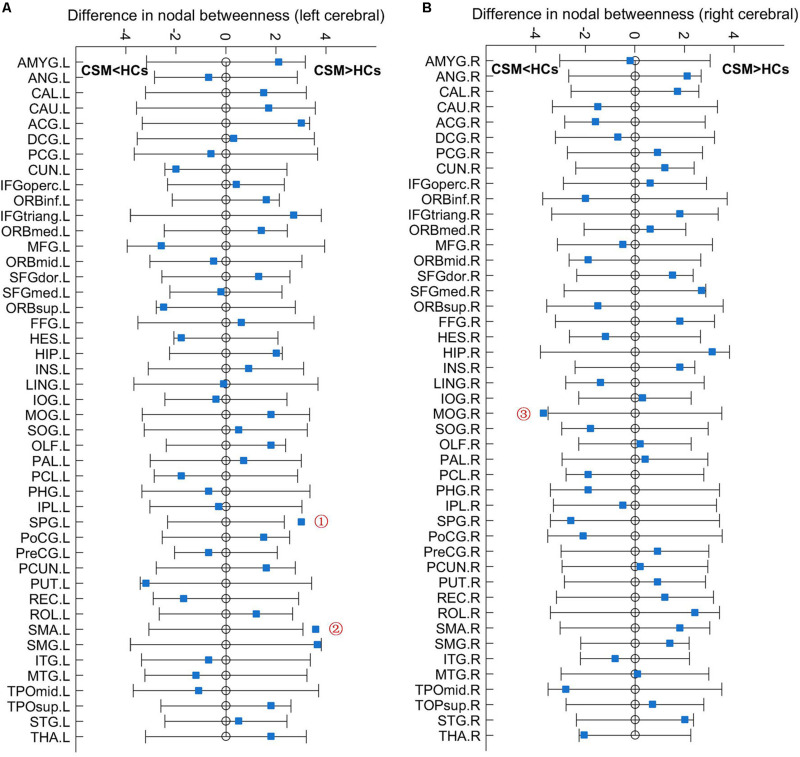
Between-group differences in nodal betweenness in 45 left cerebral regions (A) and 45 right cerebral regions (B) of AAL atlas. The open circles represent the mean values and the gray bar lines represent the 95% confidence intervals of the between-group differences obtained 1000 permutation tests. Patients with CSM had significantly increased betweenness in the left superior parietal gyrus (SPG.L, indicated as ➀ in panel A) and left supplementary motor area (SMA.L, indicated as ➁ in panel A) and significantly decreased betweenness in the right middle occipital gyrus (MOG.R, indicated as ➂ in panel B) compared to HCs. For the full forms of the abbreviations used to denote the brain regions, see Table 1.